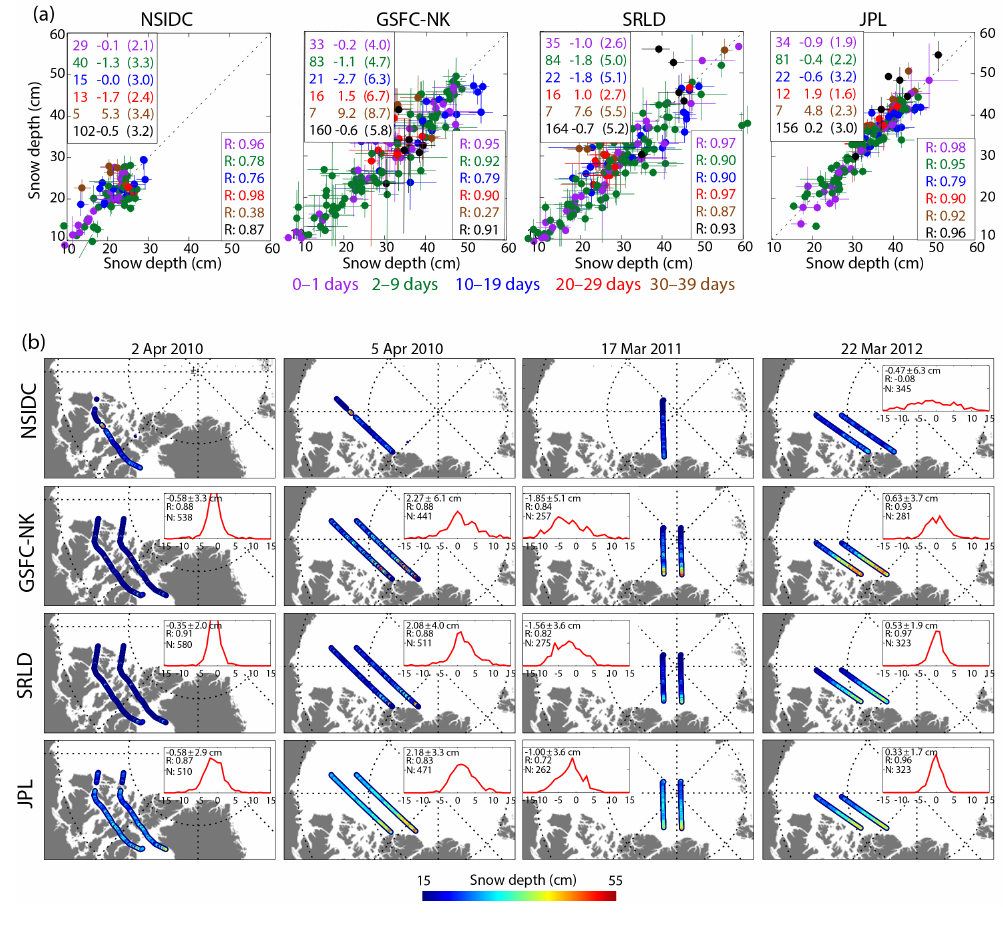
Figure 9. Differences of snow depth retrievals at crossovers and repeat tracks. (a) Crossovers with varying time separation. Mean and standard deviation of differences and correlation coefficients ( R ) are shown on each plot. (b) Repeat tracks: 2 April 2010, 5 April 2010, 17 March 2011, and 22 March 2012. Inset shows the distribution of differences and quantities show mean and standard deviation of differences, correlation, and sample population. Each sample represents the mean snow depth in a 4km along-track segment. (Note: on 21 April 2009, the snow radar was operated with an altitude difference of ∼ 300m in the outbound and return